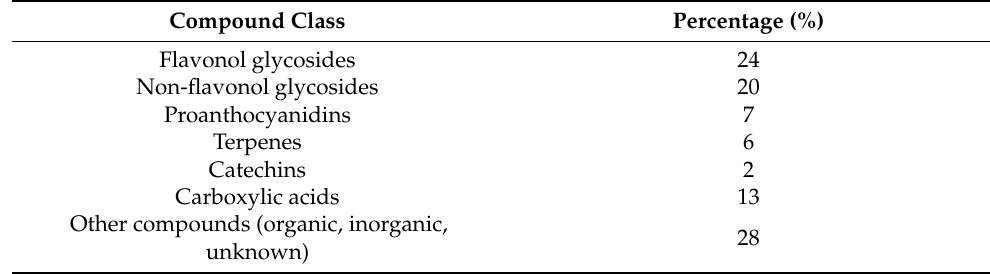
Table 1. Main classes of chemical compounds present in EGb 761 ® (Adapted from